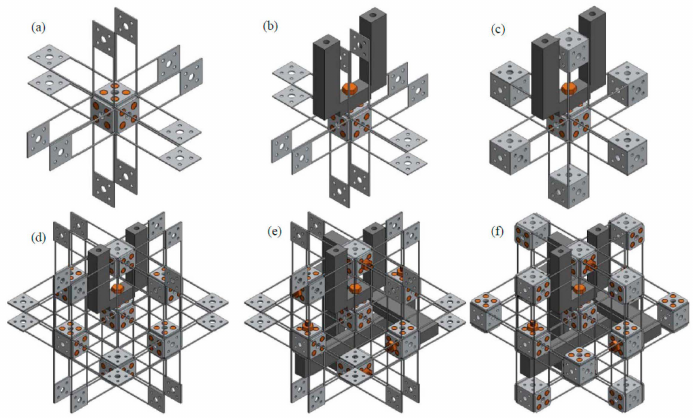
Figure 14. Assembling process of the design-I: ( a ) MS and its connected compliant beam components assembly, ( b ) output platform linkage assembly, ( c ) ASs assembly, ( d ) AS connected compliant beam components assembly, ( e ) rigid cube linkage assembly and ( f ) other rigid cubes